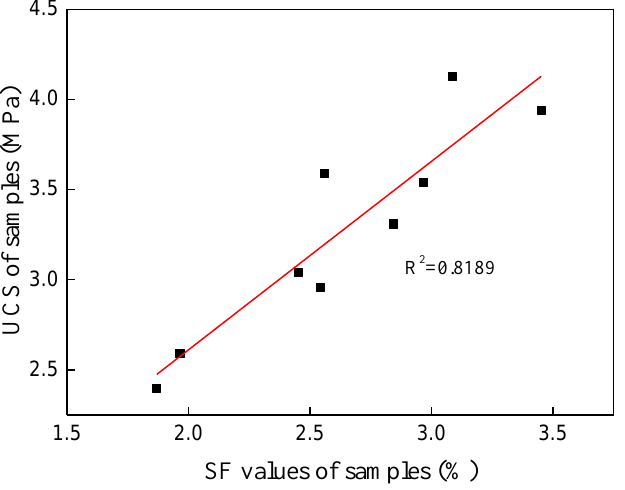
Figure 10. Comparison chart of the strength factor (SF) values and UCS of samples in row 2.